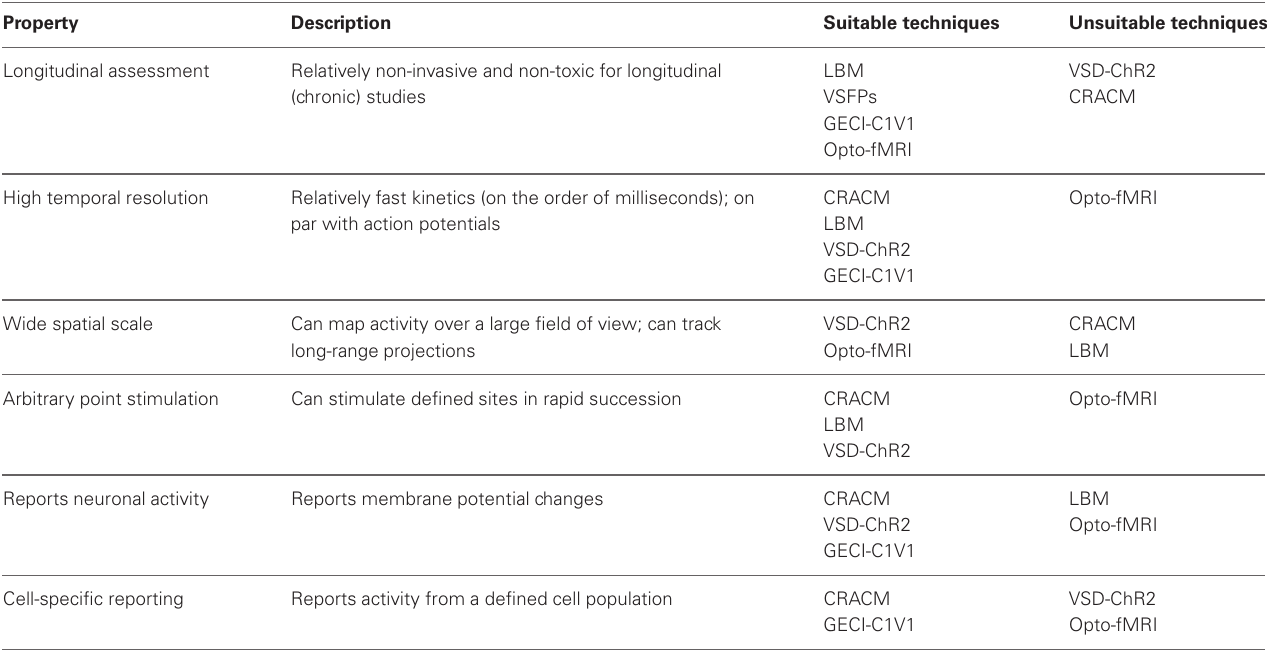
Table 2 | Properties of an ideal functional mapping technique.